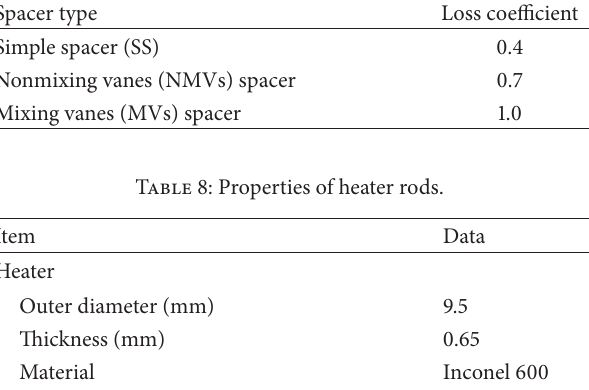
Table 9: Accuracy of process parameters in void distribution